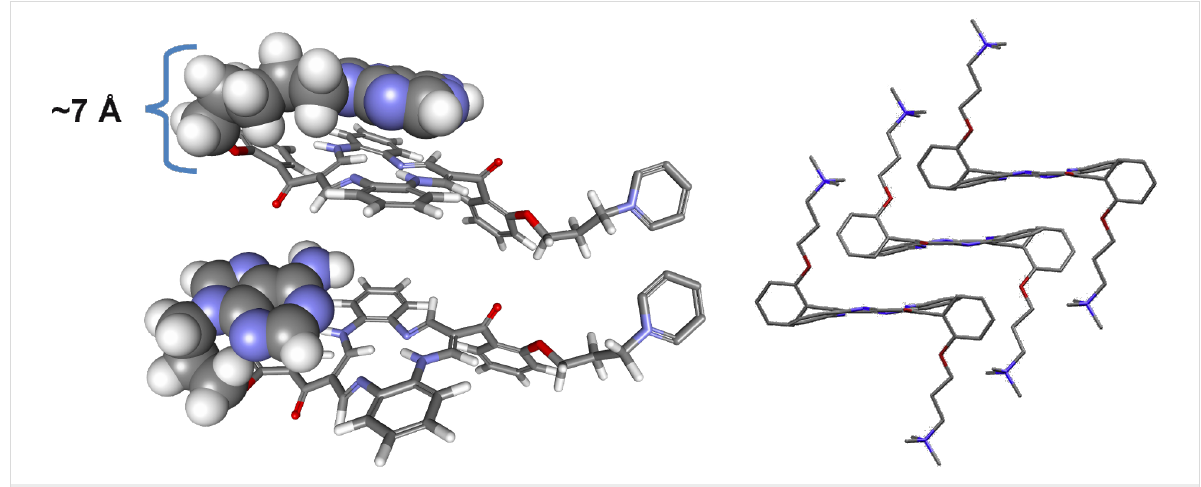
Figure 4: Self-folding of AP5 (upper left – note the stacking of DBTAA and adenine) and AP3 (lower left – note the short linker which does not allow for the stacking of DBTAA and adenine); (right) detail of three molecules packing in crystal by π – π stacking of parallel DBTAA rings with a distance of ca. 3 Å (see [13] and Figure 8